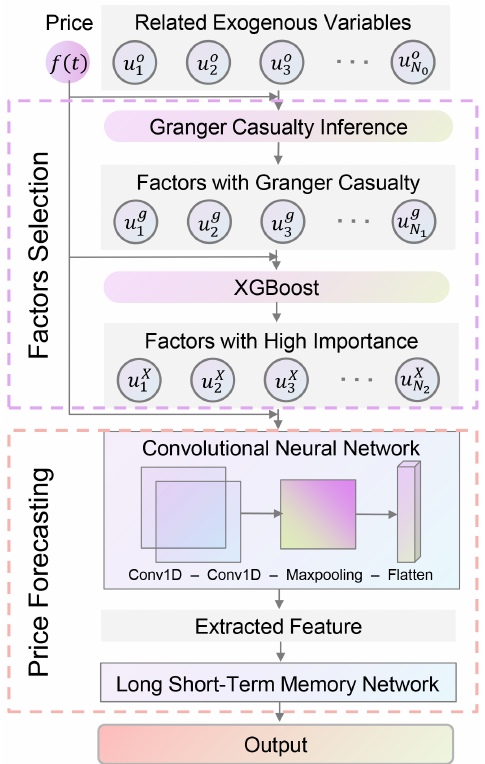
Figure 3. The schematic diagram of the proposed MFSFCL